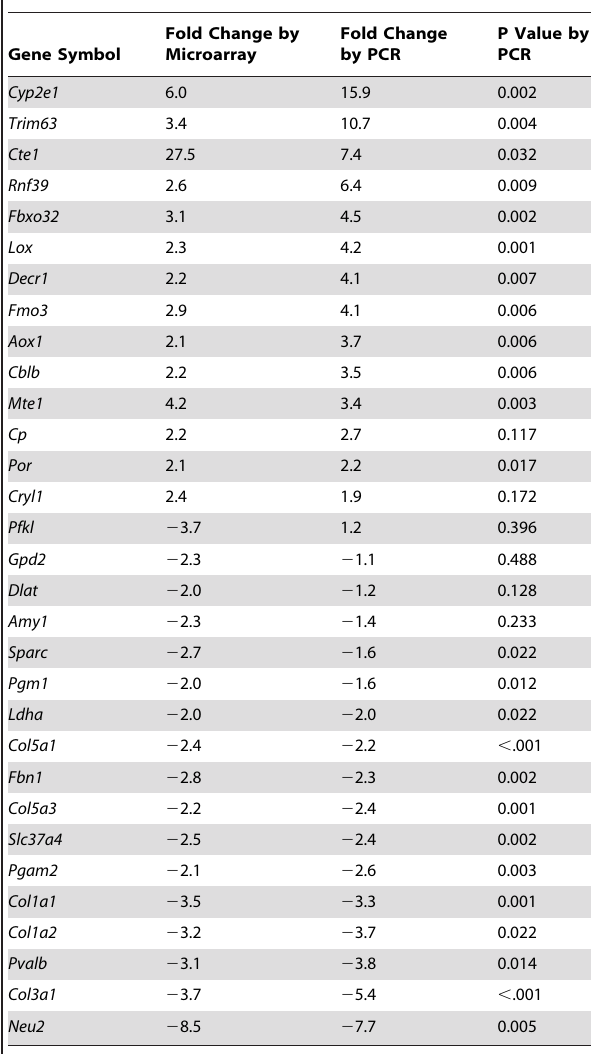
Table 5. Changes in gene expression measured by real-time PCR.